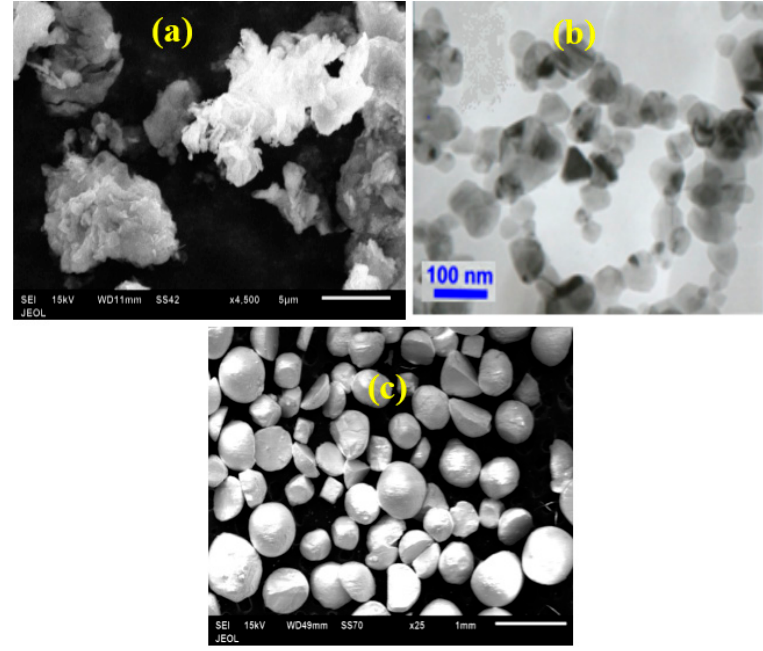
Figure 1. Micrographs of ( a ) pure aluminum powder; ( b ) SiC powder [20] and ( c ) NaCl particles.